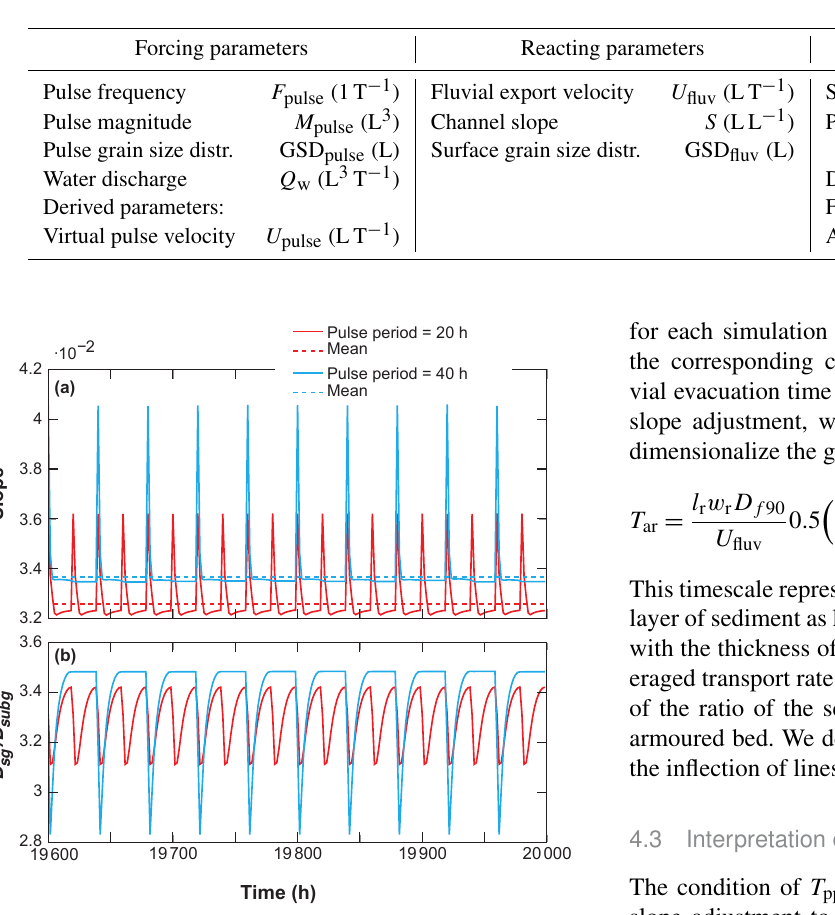
Figure 5. (a) Slope and (b) armouring ratio for the last 400h of 2 out of 40 experiments using σ = 1 . 6. A run with a low event fre- quency is shown in blue, and a run with a high event frequency is shown in red. In these example runs the mean slope in equilibrium is higher for the run with longer pulse